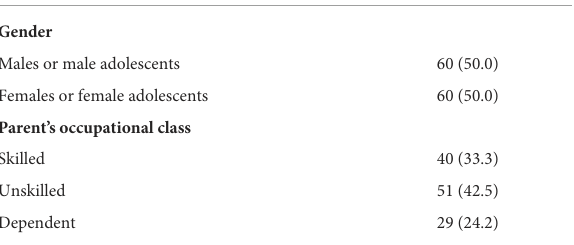
TABLE 1 Sociodemographic characteristics of the adolescents. Sociodemographic characteristics ( n =